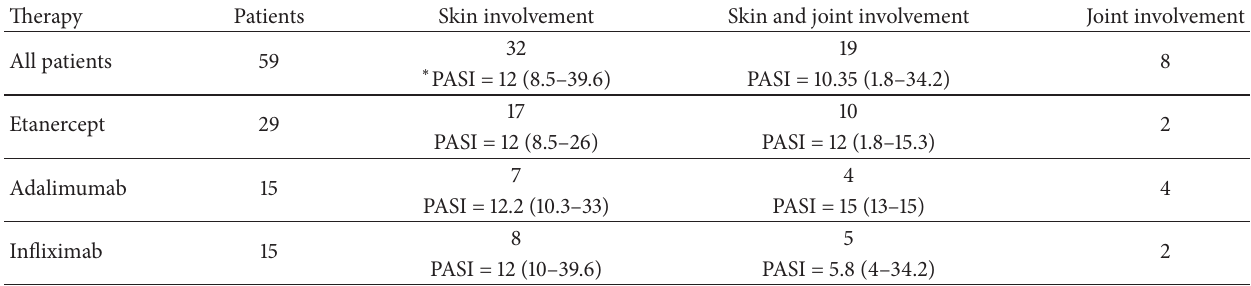
Table 2: Clinical efficacy of TNF- 𝛼 inhibitors on skin